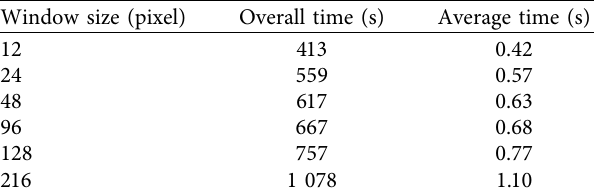
Table 3: Comparison of real-time performance of SSIM algorithm at different filter scales.